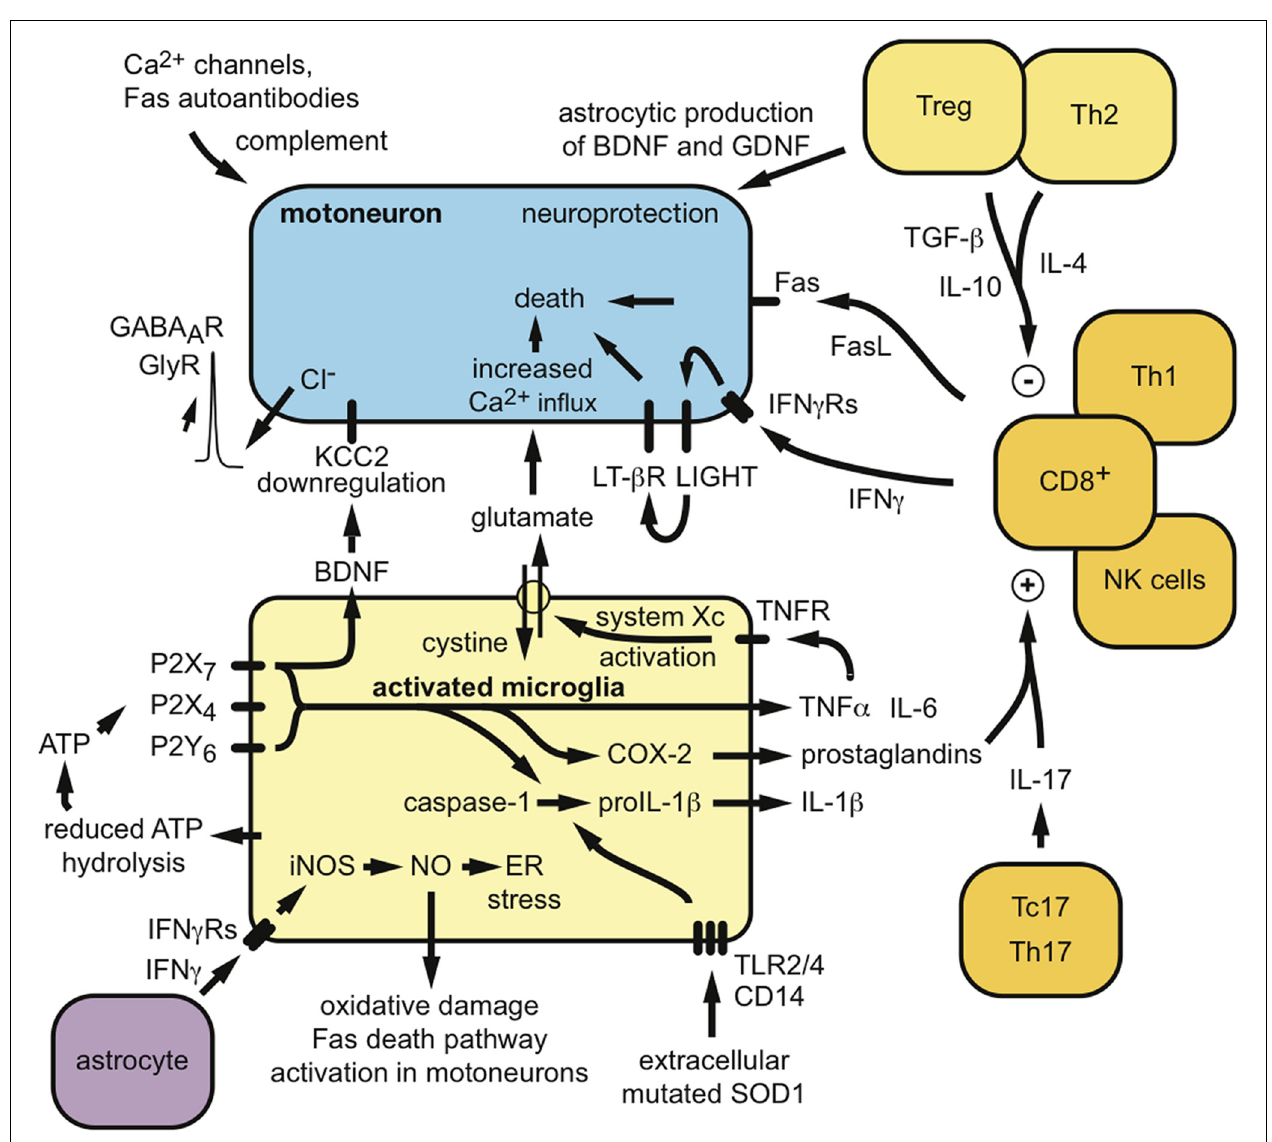
FIGURE 1 | Potential mechanisms by which peripheral and central immunity might contribute to the neurodegenerative process inALS. Both neuroprotective and neurotoxic functions can be proposed for the involvement of microglia and lymphocytes in ALS